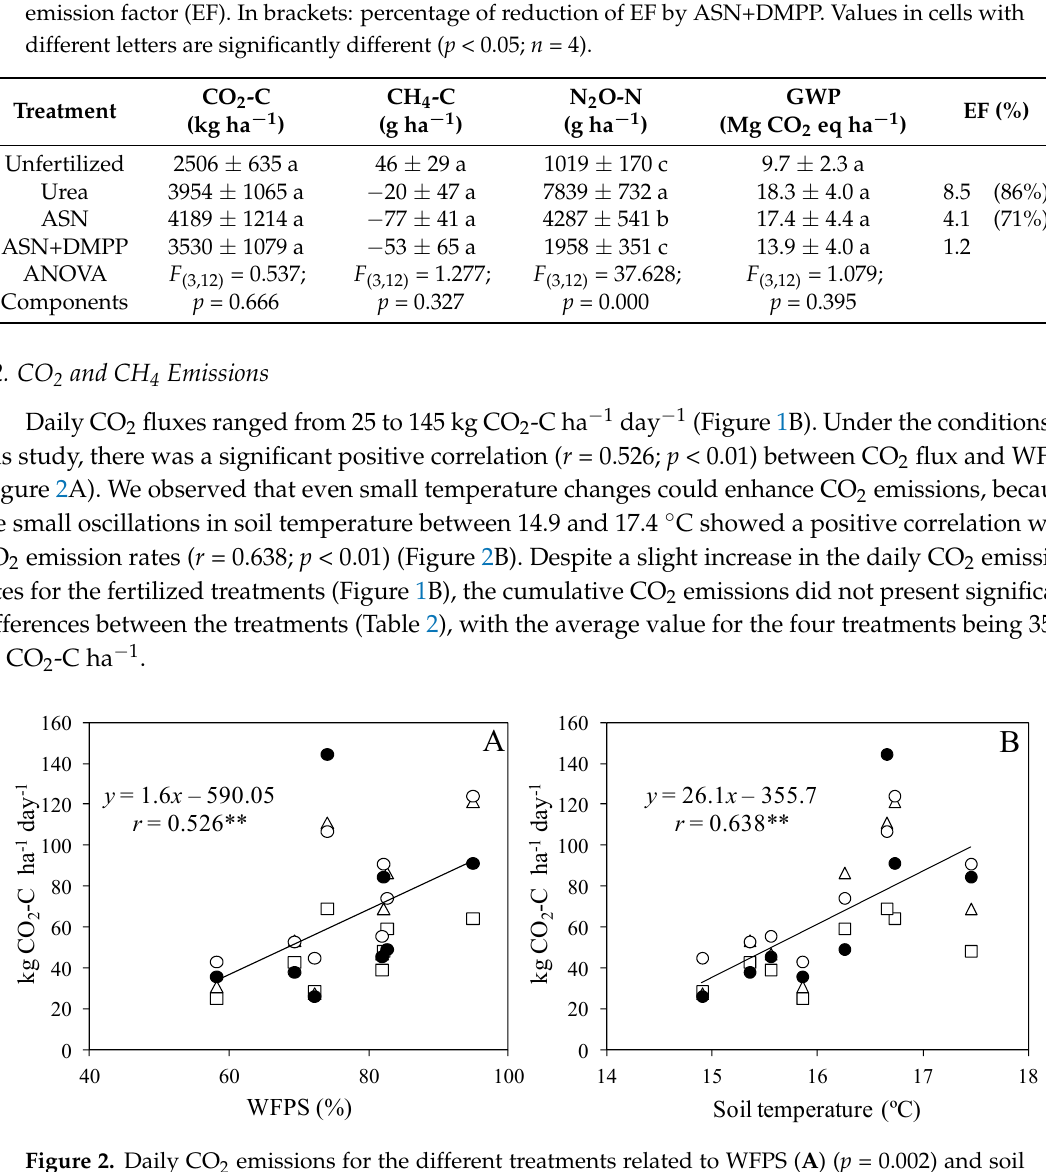
Table 3. Yield (dry matter (DM) production), crude protein (CP) content, acid detergent fiber (ADF) content, nitrogen use efficiency (NUE), and apparent nitrogen recovery (ANR). Values in cells with different letters are significantly different ( p < 0.05; n = 4).